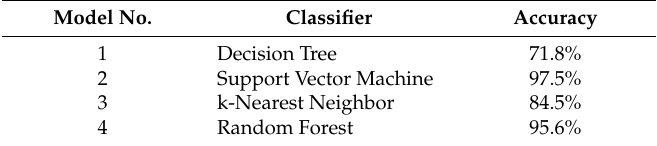
Table 8. Performance comparisons of Machine Learning models of DPM.